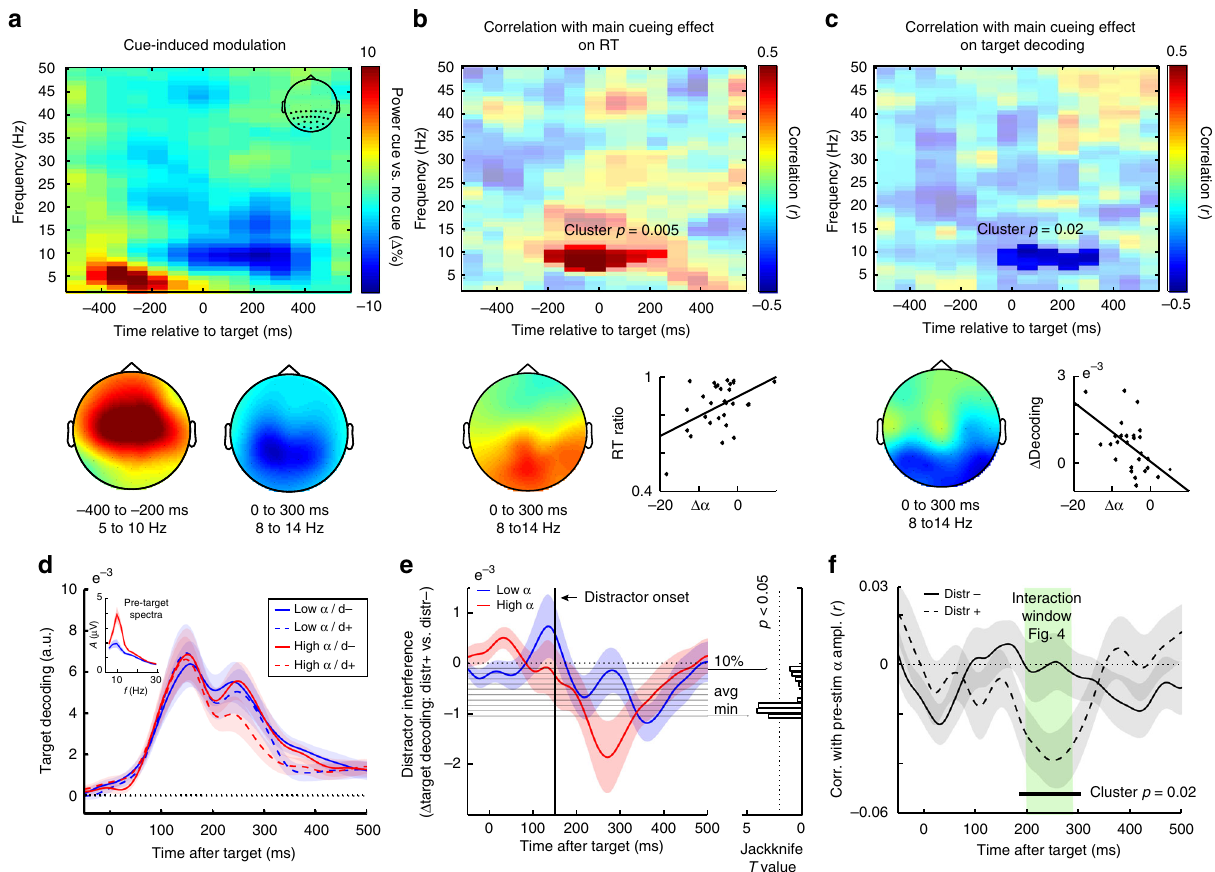
Fig. 6 Attenuated posterior alpha oscillations predict enhanced target decoding (across participants) and distractor resistance (across trials). a Time- frequency plot of the cue-induced modulation in spectral power, expressed as a percentage change (i.e., ((cued − uncued)/(uncued))×100). Data from all posterior electrodes marked in the inset in the right top. Topographies show modulations from 5 to 10 Hz in the interval between − 400 to − 200 ms (left) and from 8 to 14 Hz in the interval between 0 and 300 ms post-target (right). Topographies were scaled according to the same colorbar as the time- frequency plot. b Time-frequency plot of the correlation (across participants) of the cue-induced modulation with the magnitude of the main cueing effect on reaction time (RT; expressed as a ratio between cued and uncued RTs). c Similar to panel b , except showing the correlation with the main cueing effect on target decoding (averaged over 118 to 248 ms post-target; see Fig. 4a) The participant-speci fi c magnitudes of the alpha modulation used for the scatter plots in panels b and c were extracted from the signi fi cant time-frequency clusters and only serve to show the underlying distributions. d Time courses of target decoding in uncued trials as a function of distractor presence and pre-target alpha amplitude (median split). Trials were sorted by alpha amplitude averaged over all posterior channels in the 500 ms pre-target interval. Inset shows associated pre-target spectra. e Distractor interference time courses as a function of pre-target alpha state. Same conventions as for Fig. 4b. f Time courses of the trial wise correlation between pre-target alpha amplitude and target decoding, separately for distractor-present and absent trials. Shadings represent ± 1 s.e.m. calculated across participants ( n = 30). The green shaded band in panel f highlights the similarity of the alpha-dependent decoding effect with the cue-dependent decoding effect (the interaction effect) in Fig.